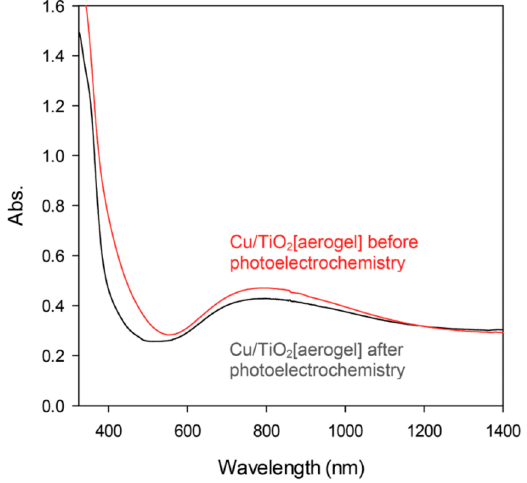
Figure 2. Diffuse-reflectance UV–visible spectroscopy of Cu nanoparticle-modified TiO 2 aerogels fabricated by photocatalytic reduction of Cu 2+ at the TiO 2 surface (a) before (red) and (b) after (gray) photoelectrochemical oxidation of methanol. Reprinted with permission from [49]. Copyright Royal Society of Chemistry, 2017.